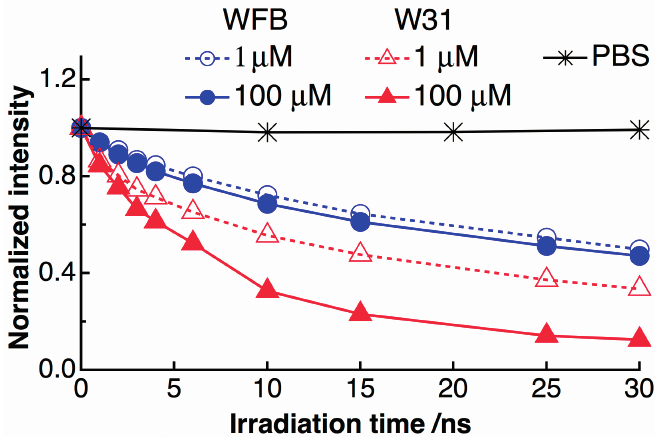
Figure 3. Plots of the fluorescence intensity of TPS against the irradiation time. Open ( ○ ) and filled ( ● ) circles are WFB cells prepared at a TPS concentration of 1 μ M and 100 μ M, respectively. Open ( △ ) and filled ( ▲ ) triangles are W31 cells prepared at a TPS concentration of 1 μ M and 100 μ M, respectively. Asterisks ( * ) are TPS in phosphate buffered saline (PBS) buffer. Each intensity is normalized by the intensity at 0